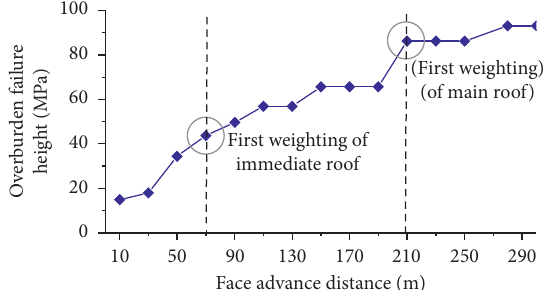
Figure 6: Change of maximum overburden failure height with face